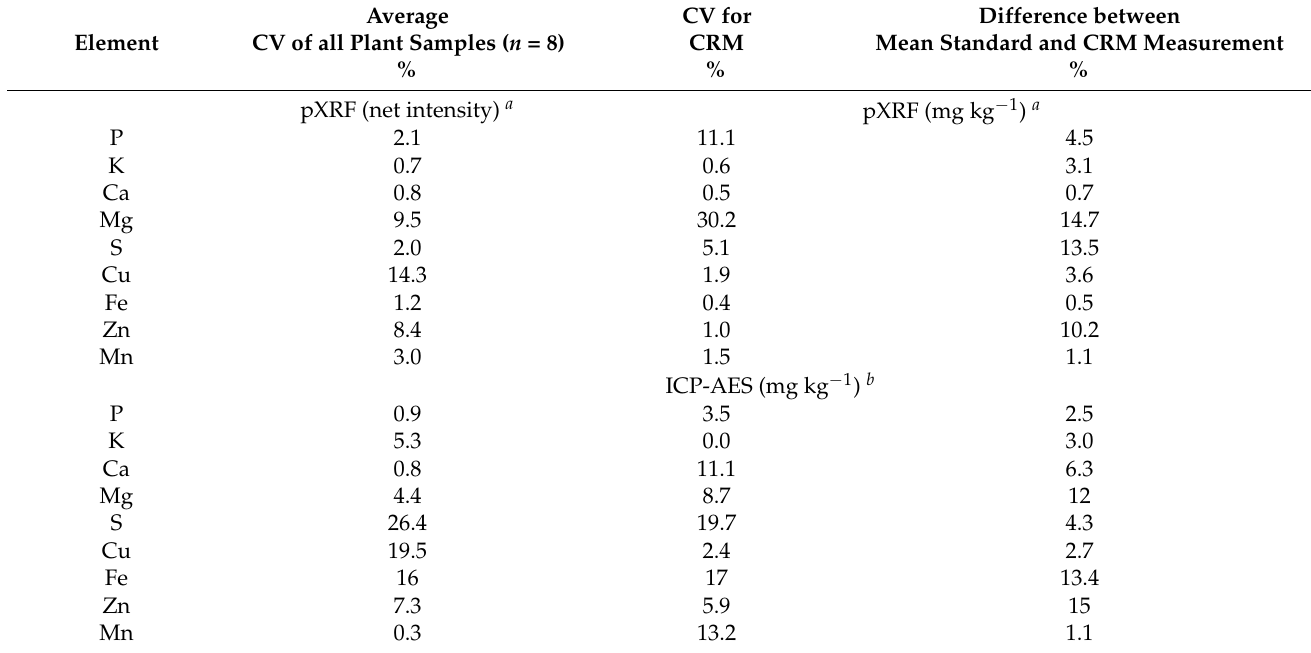
Table 1. Coefficient of variation (CV) from replicated plant samples used for modeling, and CV of the certified reference material (CRM).